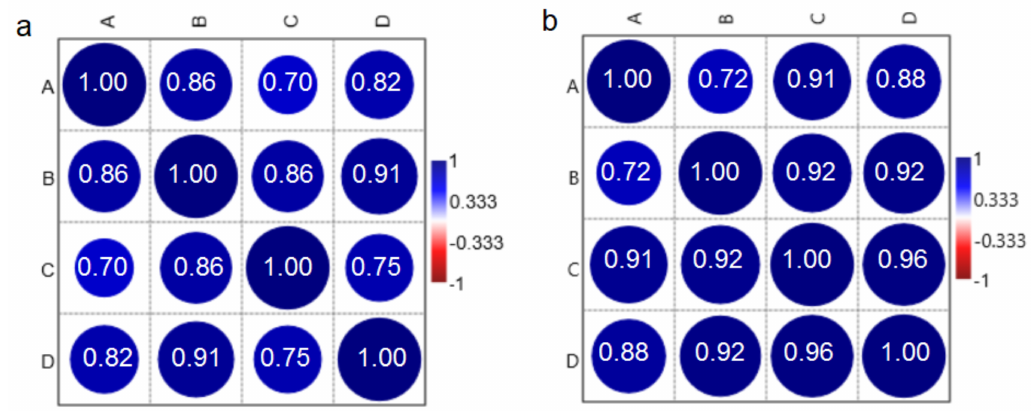
Figure 4. Pearson’s correlation test (N = 48) for the (A, C) breast cancer tissues and (B, D) LNs collected from women (A, B) without and (C, D) with the disease recurrence. Data were collected from the ( a ) Raman and ( b ) FTIR